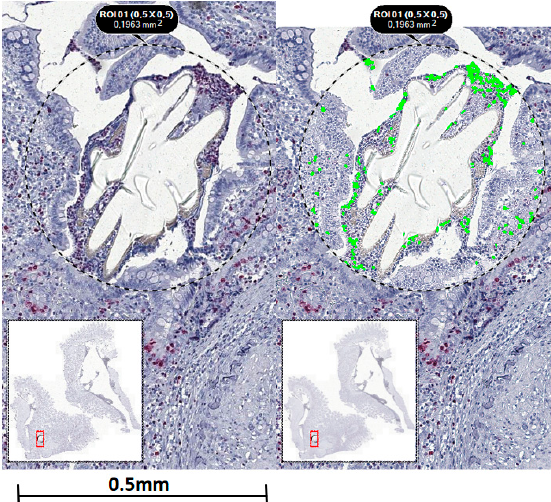
Figure 9. Example of semi-automatic analysis of the suture-tissue interface. Standard regions of interest (ROI) were set around each suture manually and then analysed automatically using StrataQuest software.